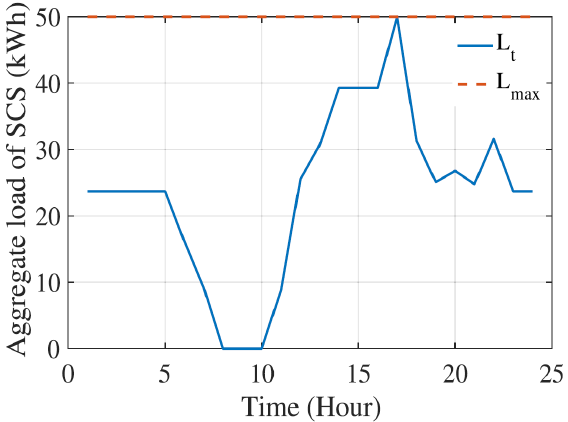
Figure 5. Charging of all PEVs at each moment acquired by Fast-ADMM.